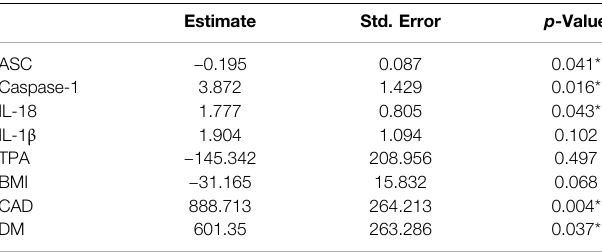
TABLE 3 | Linear regression output for factors affecting LKN time to